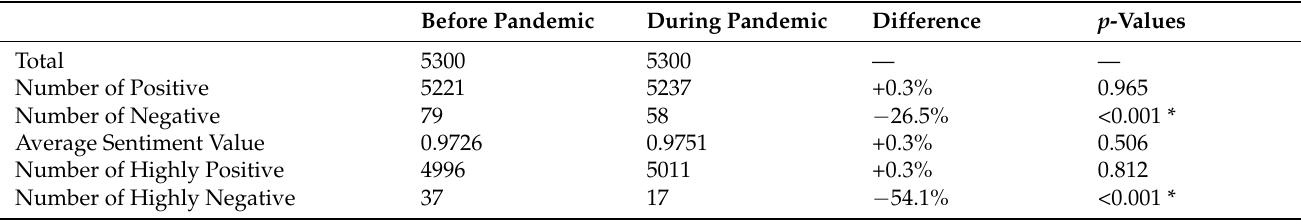
Table 3. The Numbers of Comments with Different Sentiments (Hubei).